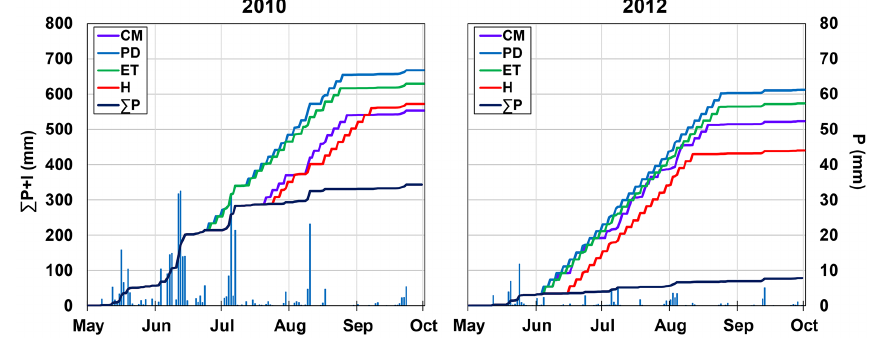
Figure 8. Example of simulated growing season cumulative P and P + I with daily P values plotted on the secondary y axis for the four irrigation routines in a wet (2010) and dry year (2012). Irrigation starts later for routines that track soil moisture, thus leading to reduced